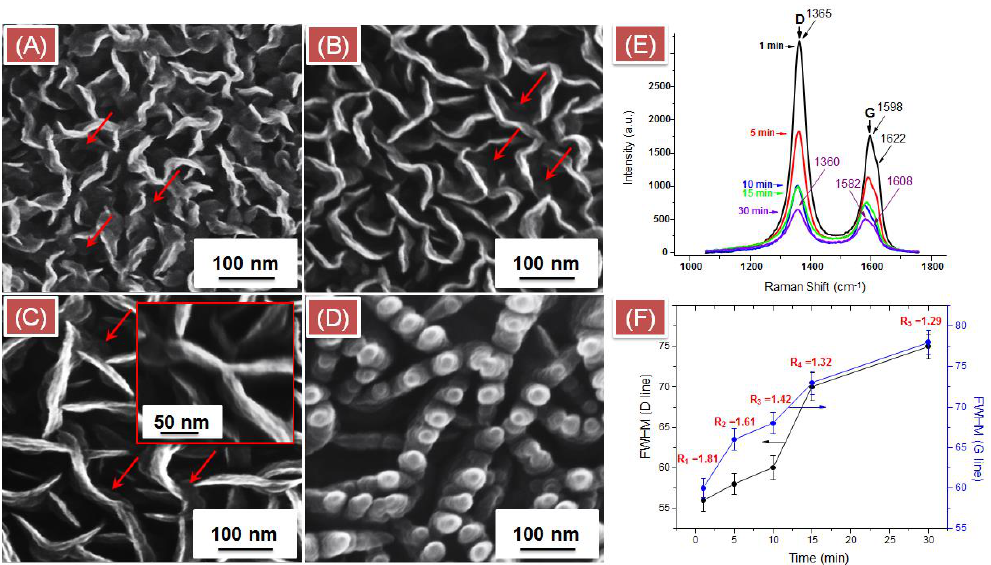
Figure 2. ( A – D ) Representative FE-SEM images of a VOG coating prepared by the ICP CVD roll-to-roll technology after 5, 10, 15 min (inset: a magnified FE-SEM image) and 30 min of deposition time at 450 °C and 1.0 Pa of total pressure; ( E ) Averaged Raman spectra of a VOG coating acquired at 473 nm excitation wavelength by using a 100× objective and 10 s of integration time. Color coding represents Raman spectra of VOG coatings being formed at different deposition time: 1 min (black, Sample 1), 5 min (red, Sample 2), 10 min (blue, Sample 3), 15 min (green, Sample 4) and 30 min (violet, Sample 5). ( F ) Full width at half maximum (FWHM) values of the D and G band lines calculated from the averaged Raman spectra versus deposition time. The “R” (in red color) represents the calculated IntD/IntG (peak height) ratio. Table 2. Calculated values of the coating height and the height of the buffer layer derived from the FE-SEM images of VOG nanostructures.